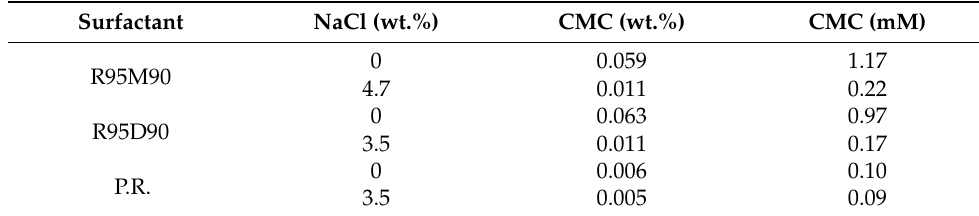
Figure 2. Pyrene fluorescence intensity I 1 /I 3 ratios for ( a ) R95M90, R95D90, and ( b ) P.R. rhamnolipid in water and in aqueous NaCl solutions. Table 1. CMC values of R95M90, R95D90, and P.R. rhamnolipids in water and in NaCl aqueous solutions, determined from pyrene fluorescence by the linear intercept of the pyrene I 1 /I 3 vs. log (surfactant concentration)